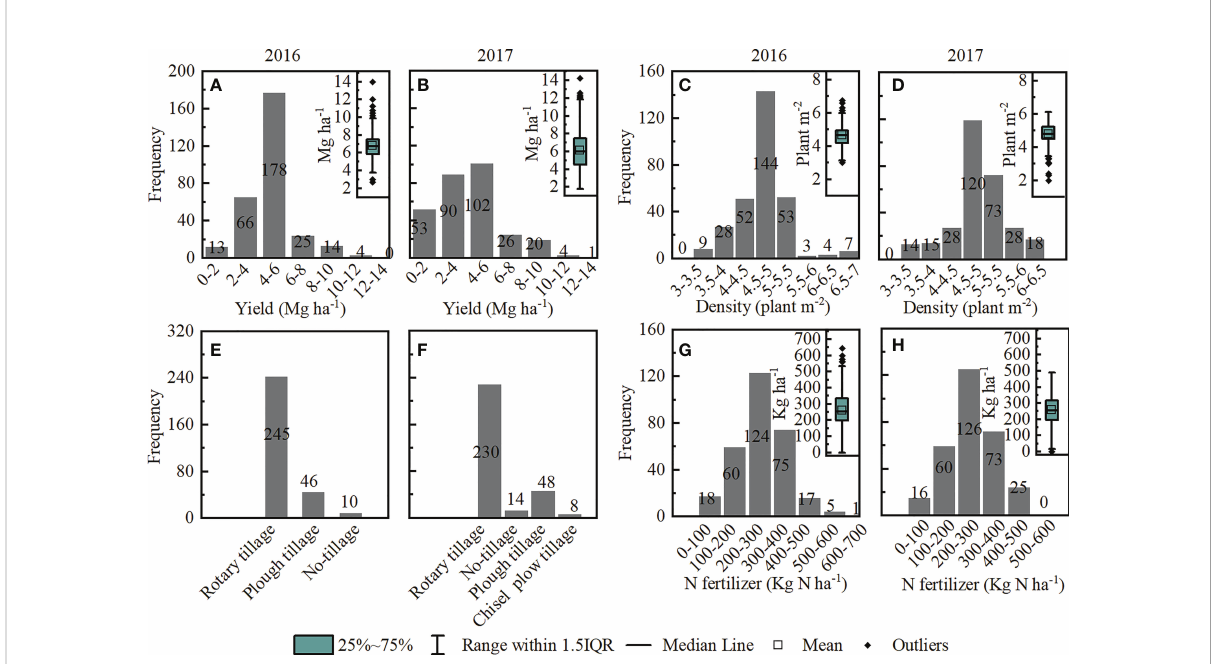
FIGURE 2 Statistics for yield, planting density, tillage methods, and nitrogen (N) fertilizer survey data of relay intercropping maize from farmers. (A, B) : grain yield in 2016-2017. (C, D) : the frequency distribution histogram and boxplot of planting density in 2016 and 2017. (E, F) : the frequency distribution histogram of tillage methods in 2016 and 2017. (G, H) : the histogram and boxplot of N fertilizer in 2016 and 2017; n =